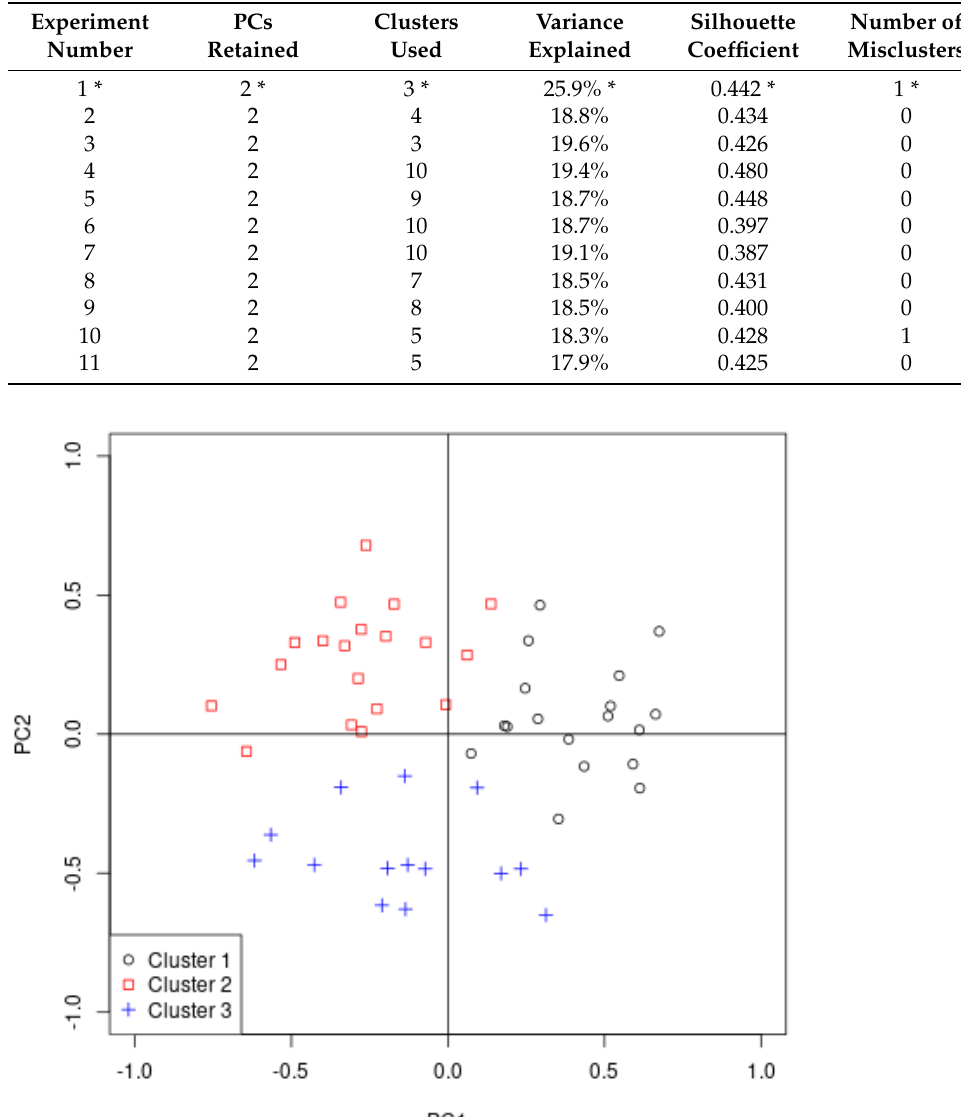
Figure 4. Scatterplot of the first two PC loadings for the 51 non-LES clippers. The x axis denotes loading vectors from the first PC and the y axis denotes loading vectors from the second PC.